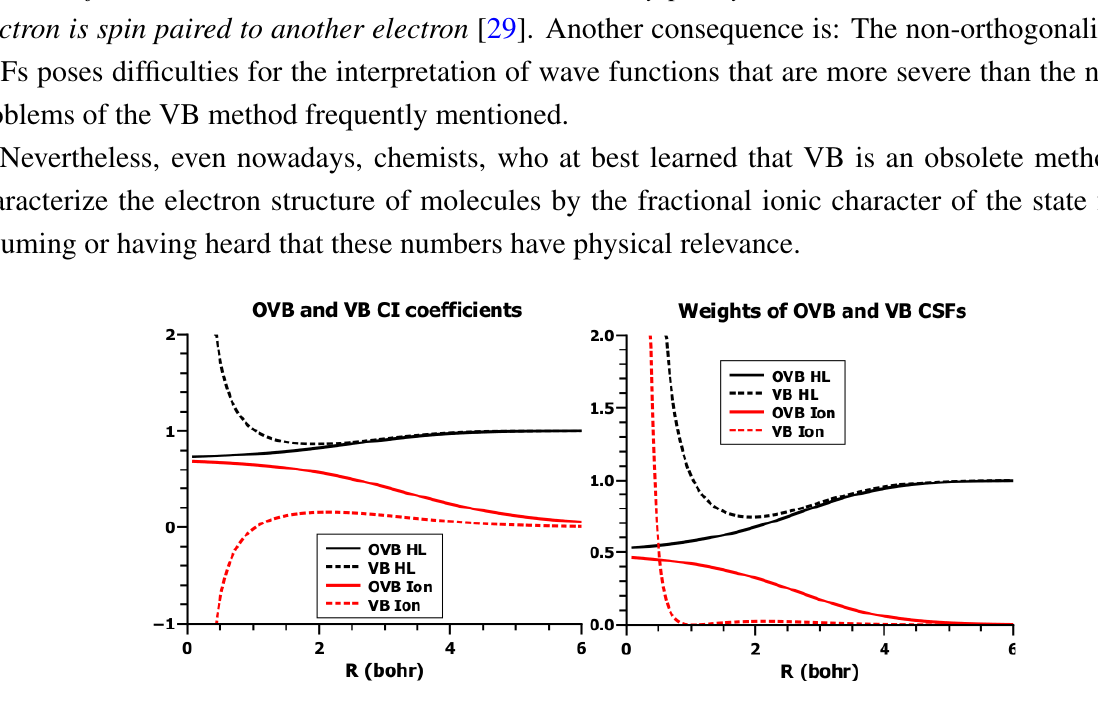
Figure 21. The CI coefficients and their squares of the (2,2)-CI problem using VB and OVB